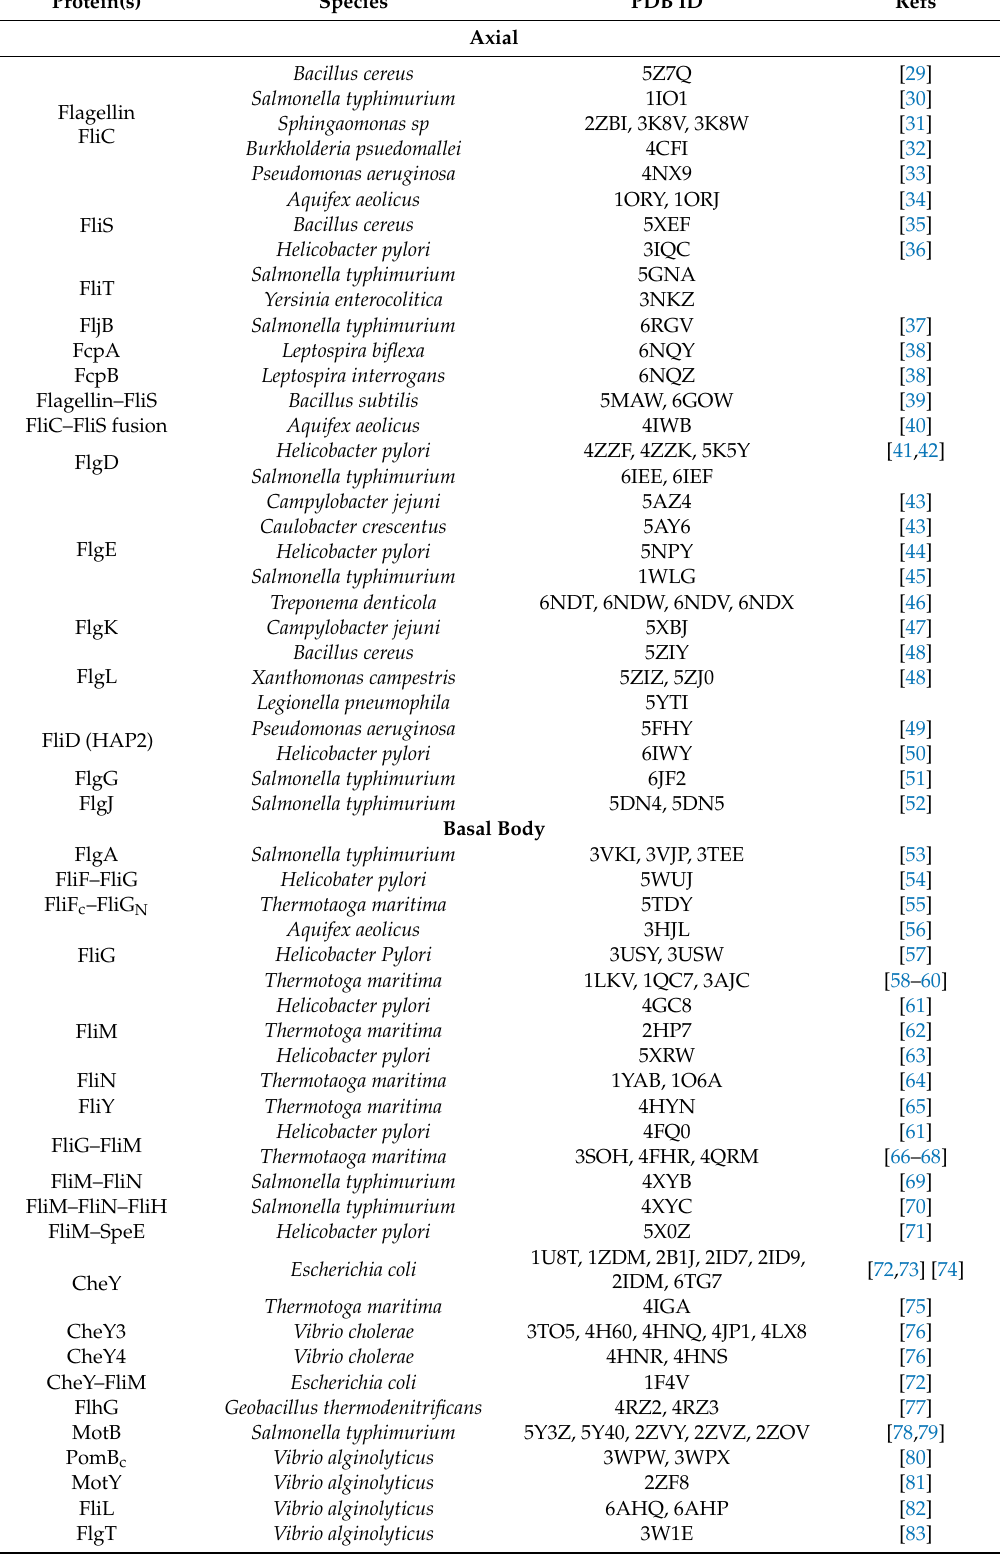
Table 1. Crystal structures of flagellar proteins. A list of the flagellar protein structures deposited in the